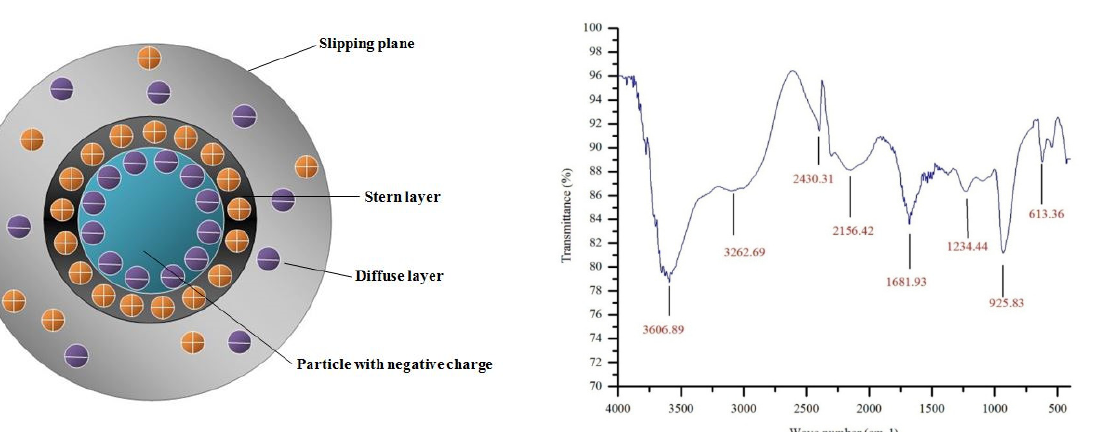
Table 3. Size distribution report of synthesized nanoparticles by intensity, by volume and by number Peaks